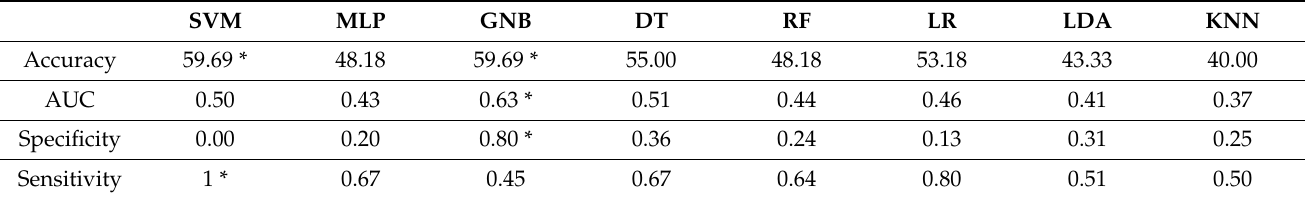
Table 4. Results of ML analysis (eight methods) for BPW indices between Groups N and CV using clinical data (23 parameters) as features. Accuracies are presented as percentages. Threefold cross- validation values are listed. “*” denotes the highest average value. The 23 clinical data points included the following: uric acid, cholesterol, HDL, LDL, GOT, GPT, glucose (random), hs-CRP, WBC, RBC, HGB, HCT, MCV, MCH, MCHC, RDW-CV, platelets, neutrophils, lymphocytes, monocytes, eosinophils, basophils, and ESR. Among the eight methods, GNB had the highest accuracy and AUC (area under receiver operating characteristic curve), which were lower than those in Table 2, for which pulse indices were used as features.